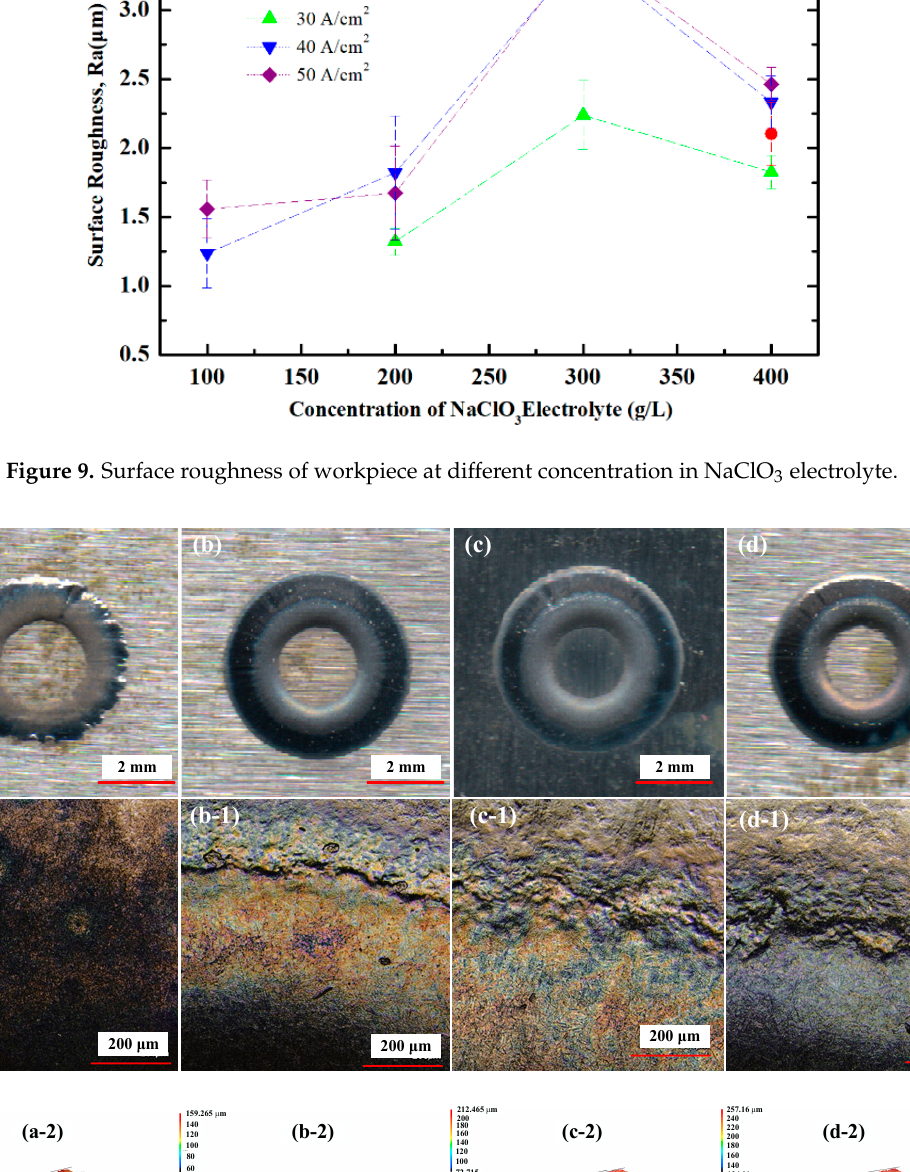
Figure 10. Surface morphology of workpiece at different concentration of NaClO 3 electrolyte: ( a ) 30 A/cm 2 , 100 g/L; ( b ) 30 A/cm 2 , 200 g/L; ( c ) 30 A/cm 2 , 300 g/L; ( d ) 30 A/cm 2 , 400 g/L. Micromorphology of workpiece local surface: ( a-1 ) 30 A/cm 2 , 100 g/L; ( b-1 ) 30 A/cm 2 , 200 g/L; ( c-1 ) 30 A/cm 2 , 300 g/L; ( d-1 ) 30 A/cm 2 , 400 g/L. 3D profile of workpiece local surface: ( a-2 ) 30 A/cm 2 , 100 g/L; ( b-2 ) 30 A/cm 2 , 200 g/L; ( c-2 ) 30 A/cm 2 , 300 g/L; ( d-2 ) 30 A/cm 2 , 400 g/L.